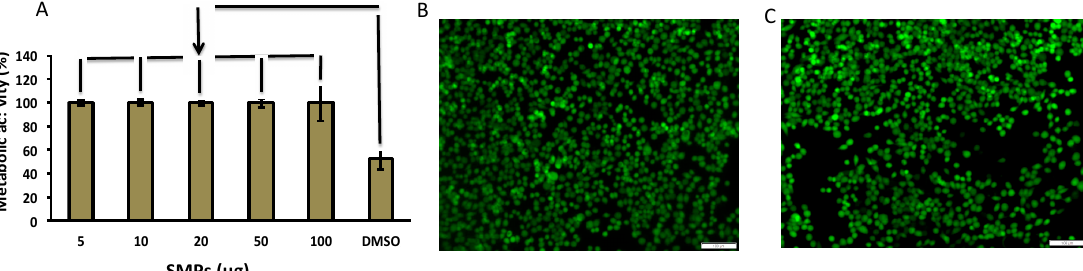
Figure 5. Cytocompatibility of the synthesized SMPs on NIH3T3 cells. ( A ) The cellular metabolic activity in the presence of SMPs was assessed by alamarBlue TM assay, and the assays showed that the metabolic activity was not affected in the presence of SMPs. ( B ) Merged fluorescence image of live cells (green channel) and dead cells (red channel) without SMPs. ( C ) Merged fluorescence image of live cells (green channel) and dead cells (red channel) in the presence of SMPs. Scale bar = 100 µm. n = 3, SD, p < 0.05, and * represents statistical significance by one-Way ANOVA.